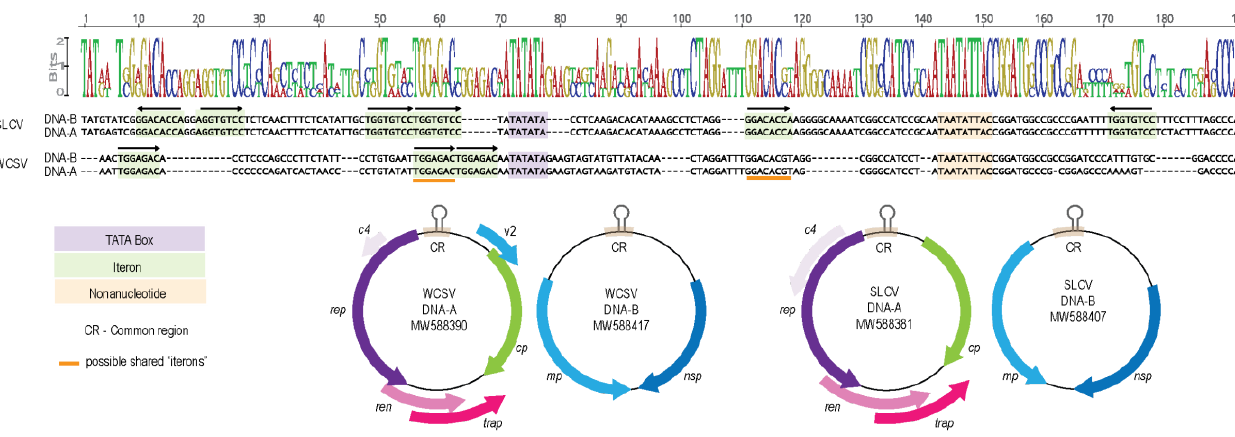
Figure 5. Alignment of the common region from SLCV and WCSV genomic components. Highlighted in purple is the TATA box, in light orange is the nonanucleotide sequence, in green are the identified “iteron” sequences for each begomovirus and the orange line indicate possible shared “iterons” between SLCV and WCSV. Graphical representation of the genomic organization of the DNA-A and DNA-B from SLCV and WCSV showing the position of the common region (CR) on the genome. rep —replication associated protein; cp —capsid protein; ren —replication enhancer protein; trap —transactivator protein; v2 —movement proteins; c4 —symptom determinant protein; mp —movement protein and nsp —nuclear shuttle protein.